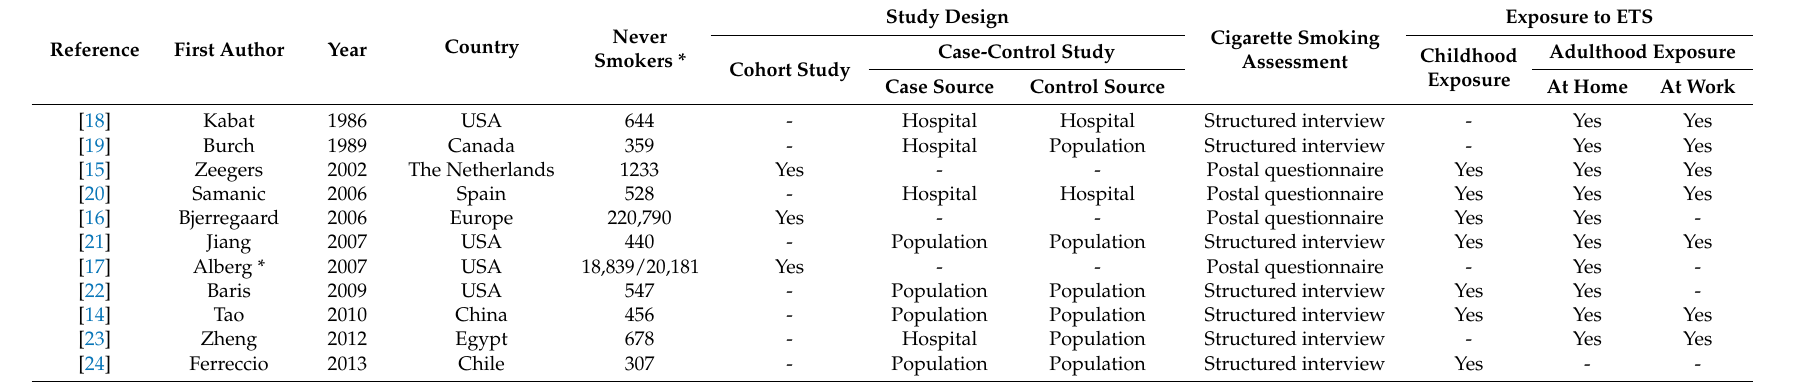
Table 1. Characteristics and type of extracted risk estimates of included case-control studies and cohort studies on exposure to environmental tobacco smoke (ETS) and urothelial by year of